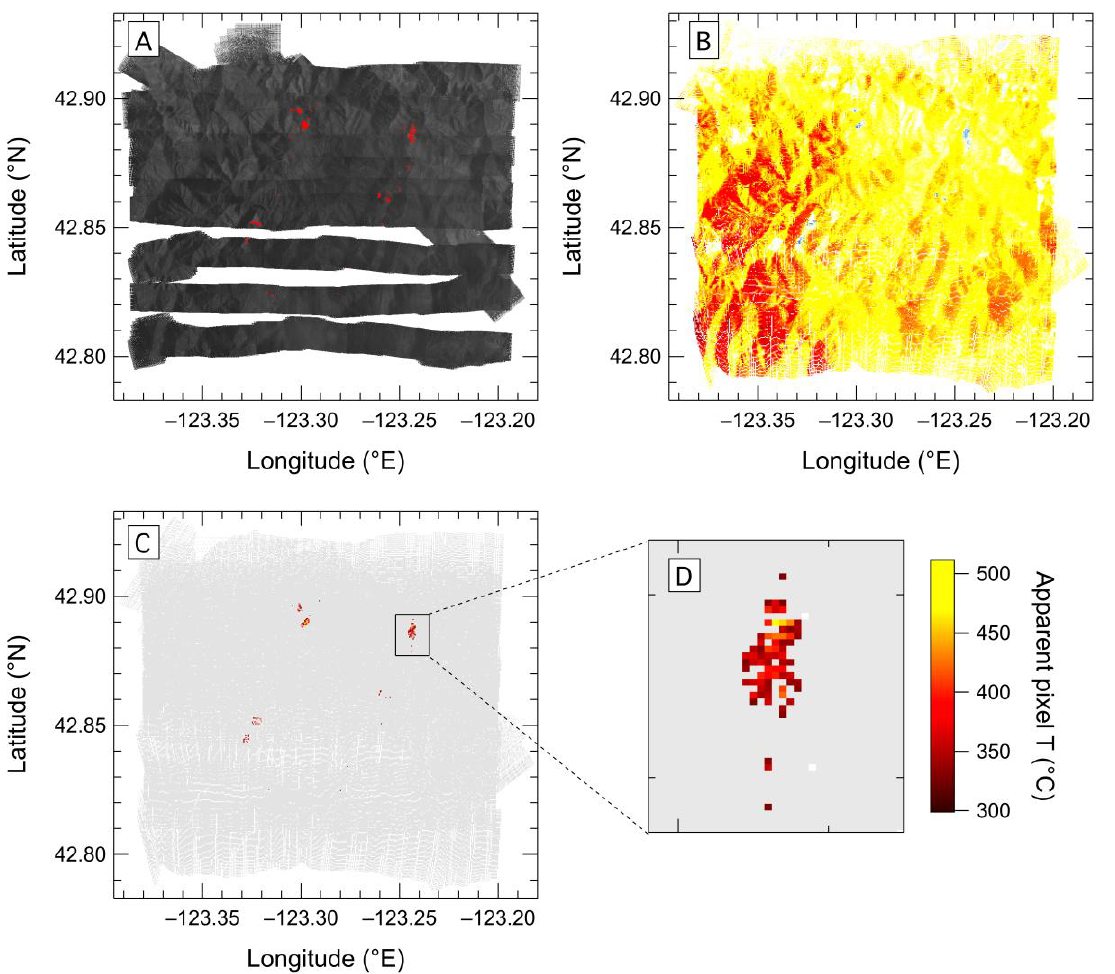
Figure 11. Maps of the Milepost 97 fire in Oregon on 27 July 2019 produced using the ( A ) SWIR camera, ( B ) 1.6 µm scanner channel and ( C , D ) 4 µm scanner channel. The flight took place during daytime, so terrain is clearly visible in the both of the SWIR sensor ( A , B ) maps. In panel ( A ), fire containing pixels are shown in red superimposed on a greyscale map. ( A ) color scale is used in ( B ) to highlight the contrast in the terrain-reflected sunlight. Detected fire locations appear as blue pixels. The 4 µm sensor ( C , D ) is blind to reflected sunlight, so non-fire pixels have a uniform background signal intensity (light grey), while fire pixels are clearly visible and the apparent temperature of the fire pixels is represented by the color scale.